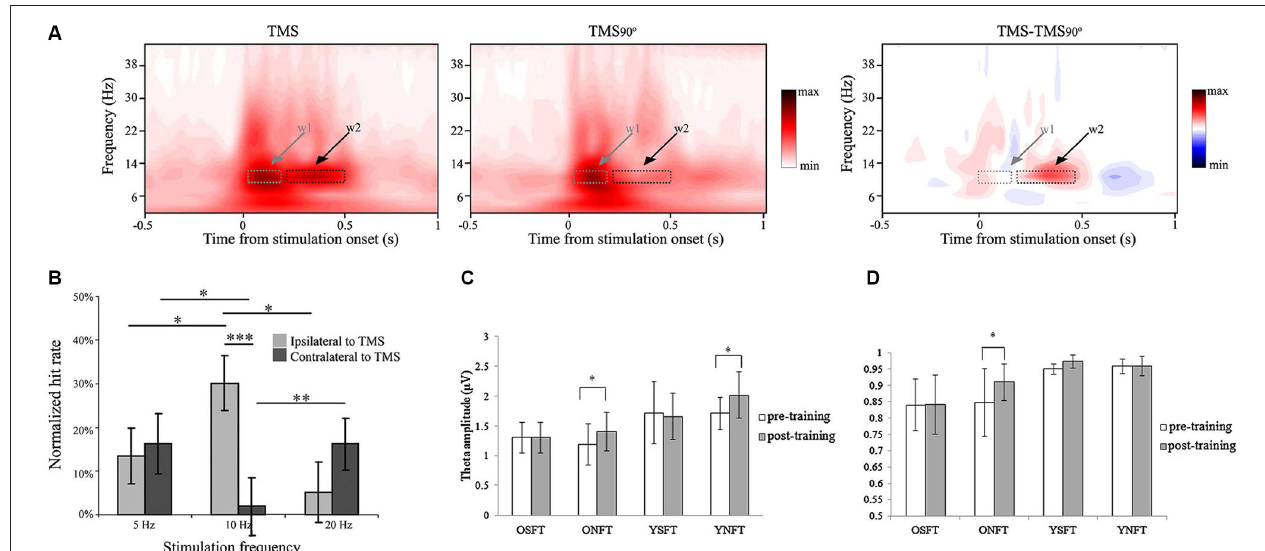
** p < 0.01, *** p < 0.001). Reproduced with permission from Romei et al. (2010). (C) Frontal theta neurofeedback training results in increased frontal theta in both young and old adults. OSFT = old subjects, sham feedback; ONFT = old subjects, neurofeedback group; YSFT = young subjects, sham feedback; YNFT = young subjects, neurofeedback (* p < 0.01). Taken with permission from Wang and Hsieh (2013). (D) Only old adults receiving neurofeedback on frontal theta increased working memory accuracy in a Sternberg task (depicted on the y-axis). Young adults were already performing at ceiling level. (for acronym, see panel C ; * p < 0.01). Taken with permission from Wang and Hsieh